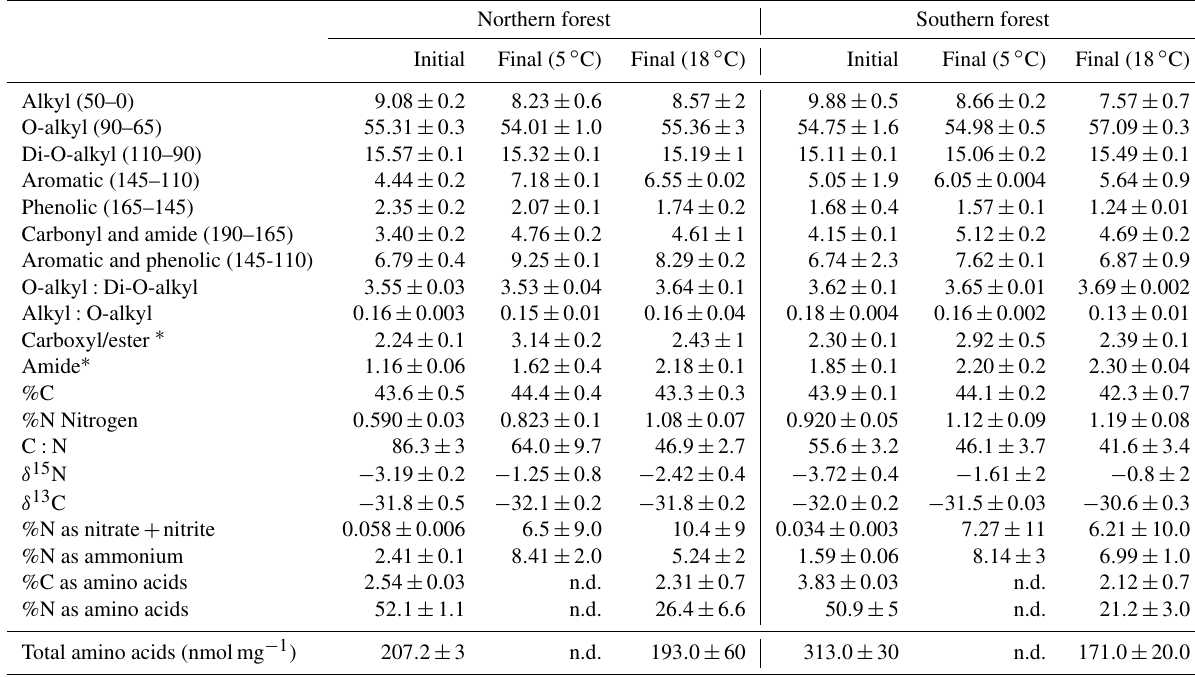
Table 3. The CPMAS 13 C-NMR results given as percentages of total C resolved for each chemical shift range, molar C-to-N ratio (C : N), and weight %C and N of the initial and final moss tissues from both sites and incubated at 5 ◦ C and 18 ◦ C top. All values are provided as the mean ± on standard deviation of three